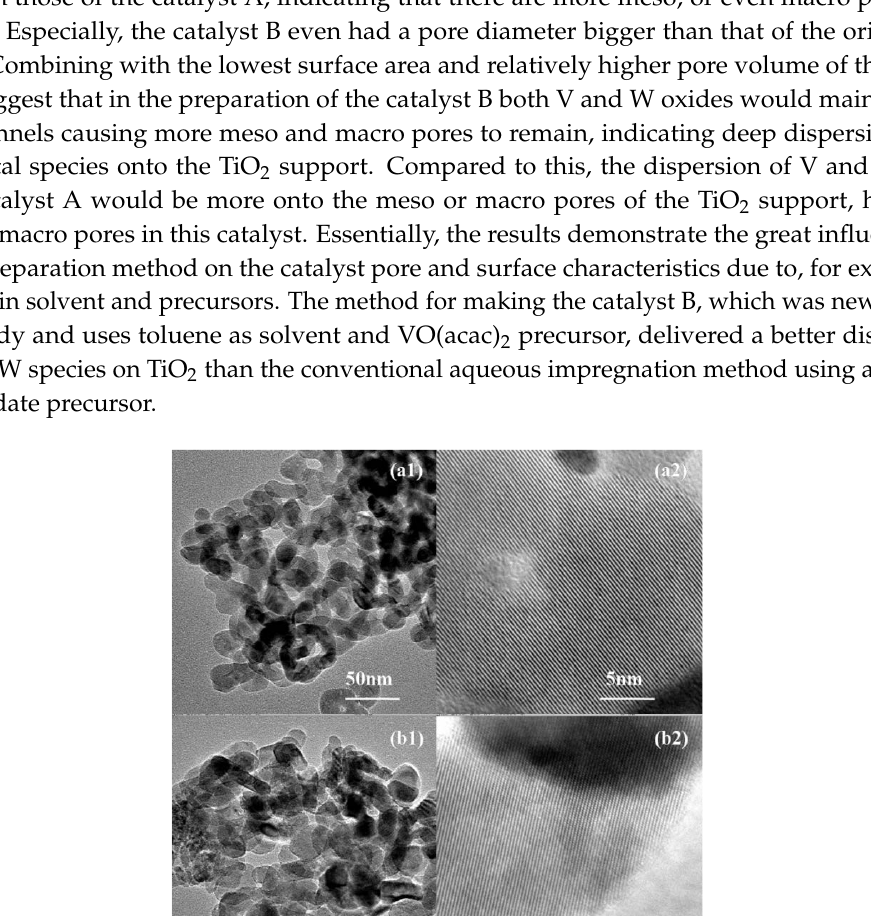
Table 1. Texture properties of the catalysts A and B and their materials.